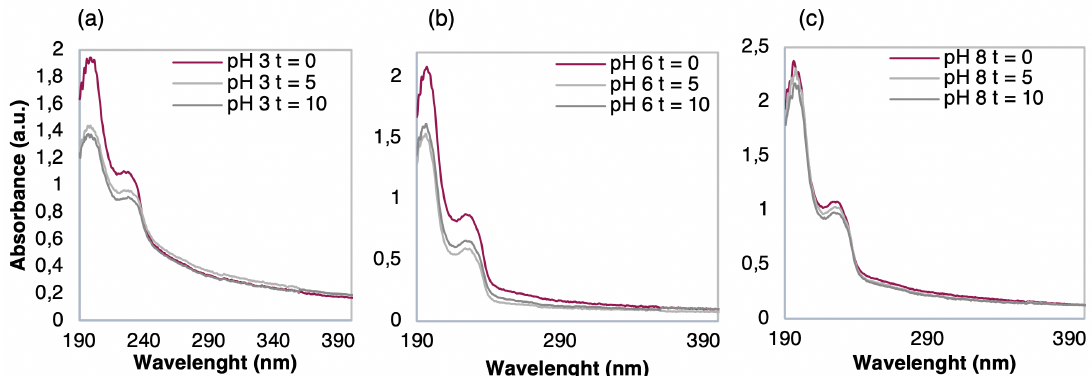
Figure 7. UV-Vis spectra of (PEI / PSS) 5 films before and after immersions times (t = 0, 5, and 10 min) in 10 − 9 M TCS solutions in EF with a pH of ( a ) pH = 3, ( b ) pH = 6, and ( c ) pH = 8.